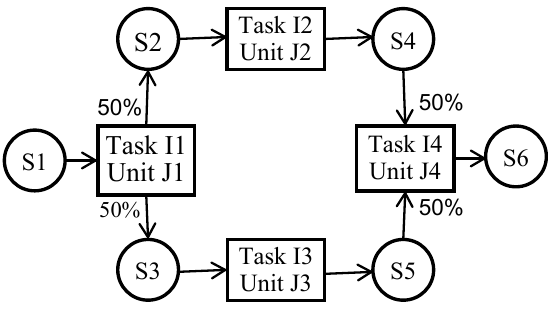
Figure 1. State-task network for Example 1 recipe.